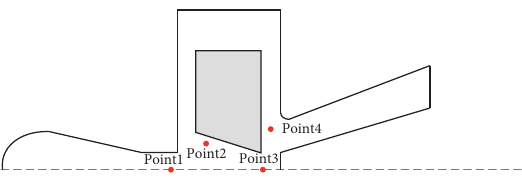
Figure 12: Monitoring points located in the